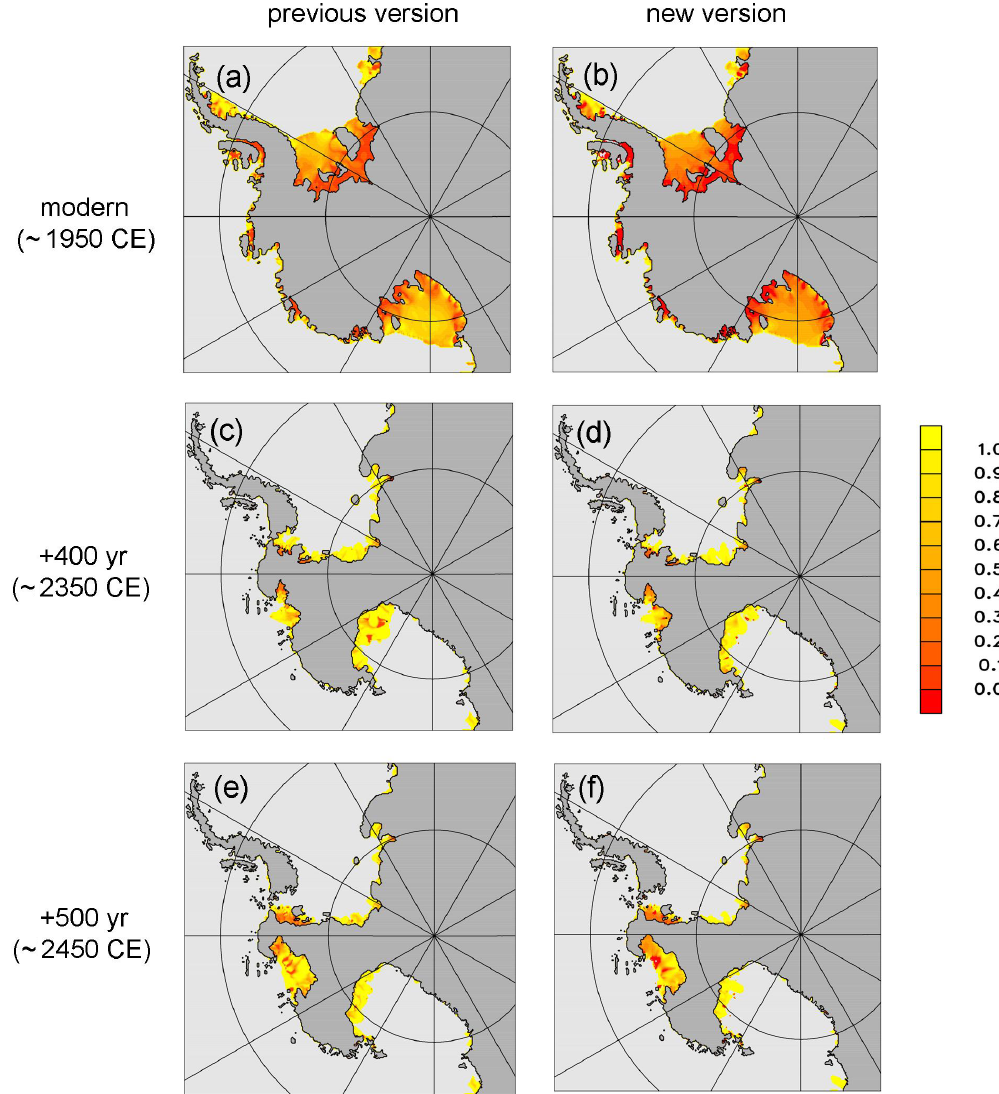
Figure 10. As Fig. 9 showing buttressing factor θ (diagnostic except at grounding